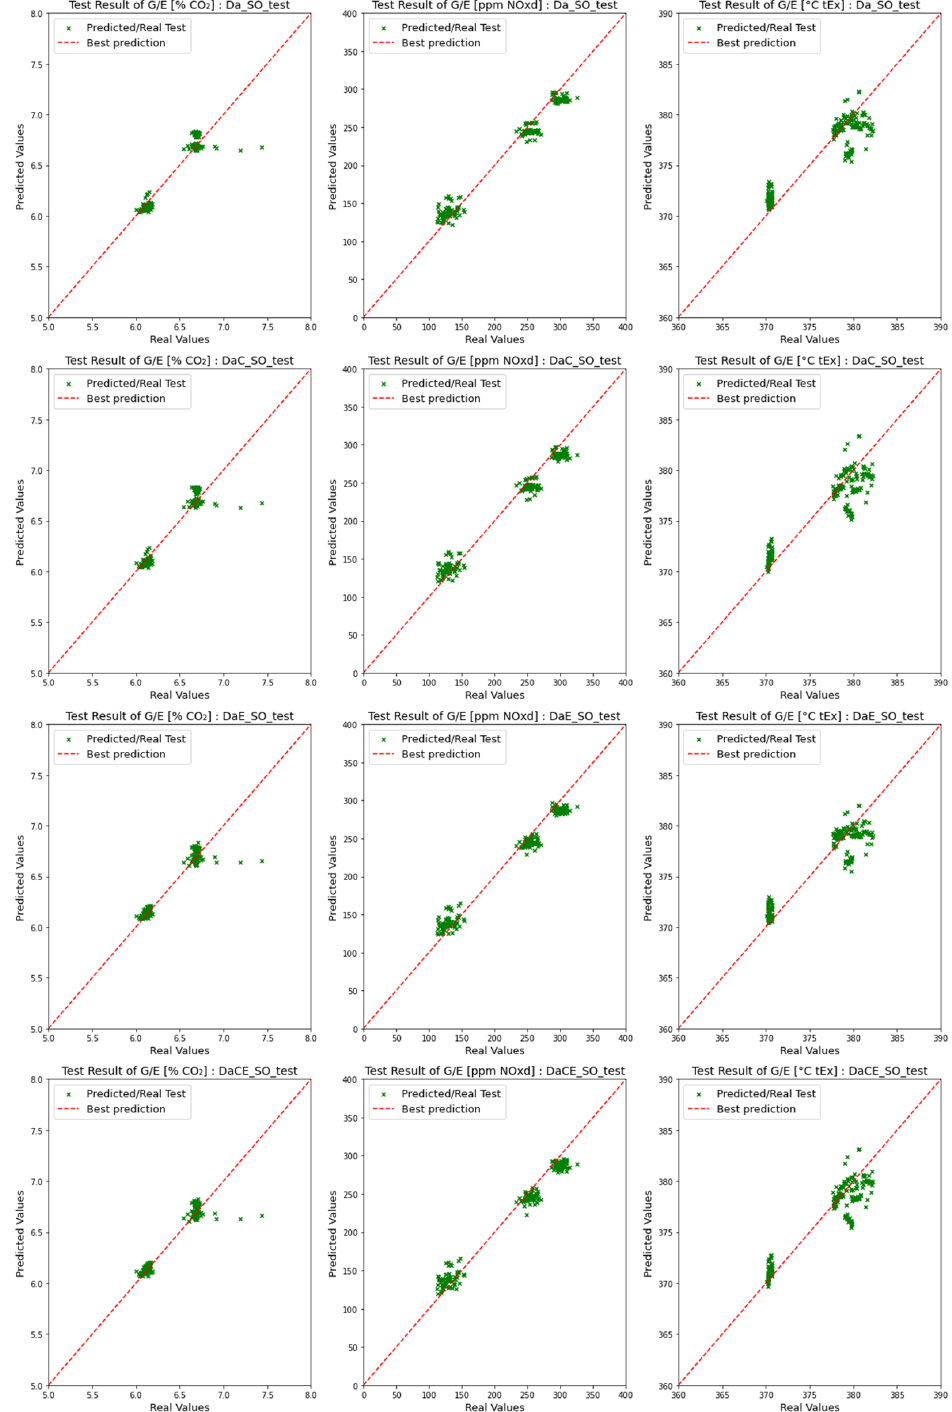
Figure 13. Comparison of dataset performances for SVM model with the SCR mode.